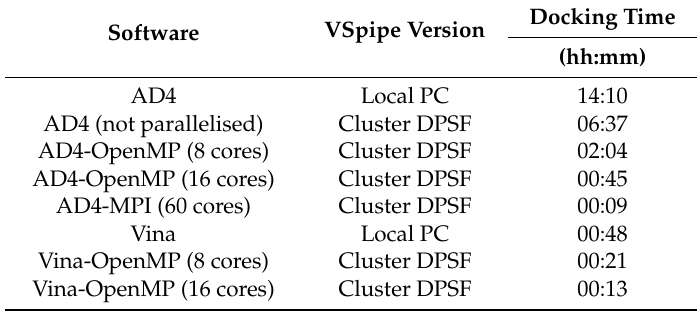
Table 1. VSpipe performance using AD4 or Vina. A comparison of the CPU time using VSpipe-local or VSpipe-cluster and the different docking methods (AD4 or Vina). The blind docking was carried out with the library Maybridge Pre-Fragment-NCO (98 fragments) on the target protein PTP1B.